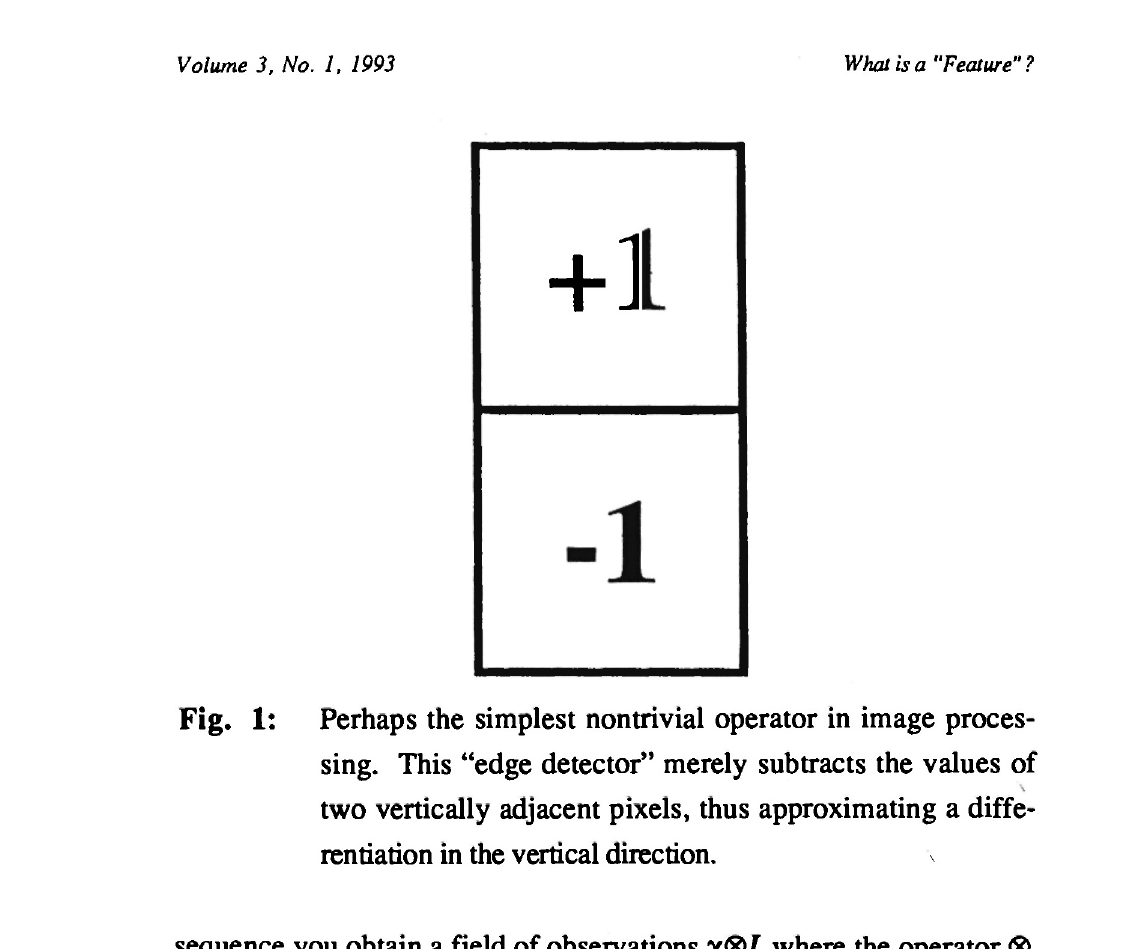
Fig. 1: Perhaps the simplest nontrivial operator in image proces- sing. This "edge detector" merely subtracts the values of two vertically adjacent pixels, thus approximating a diffe- rentiation in the vertical direction.